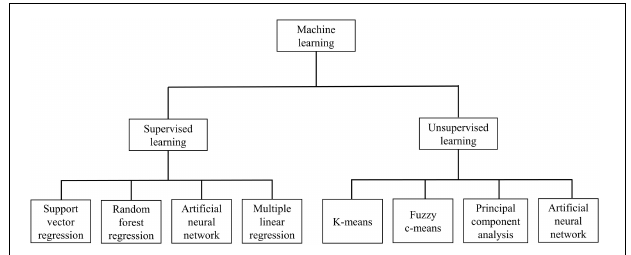
FIGURE 5 | The types of machine learning